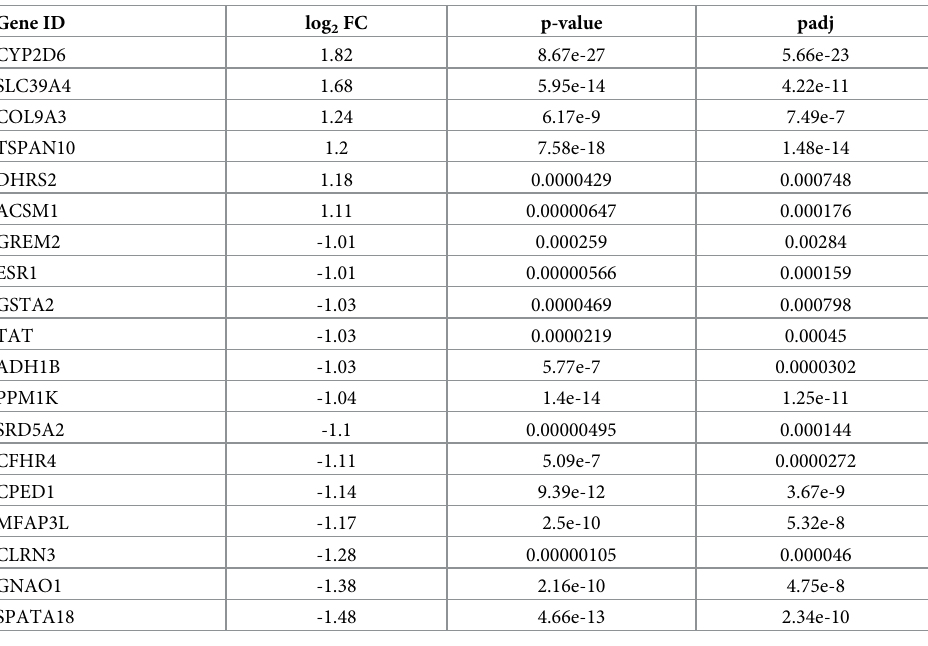
Table 1. The common genes with differential